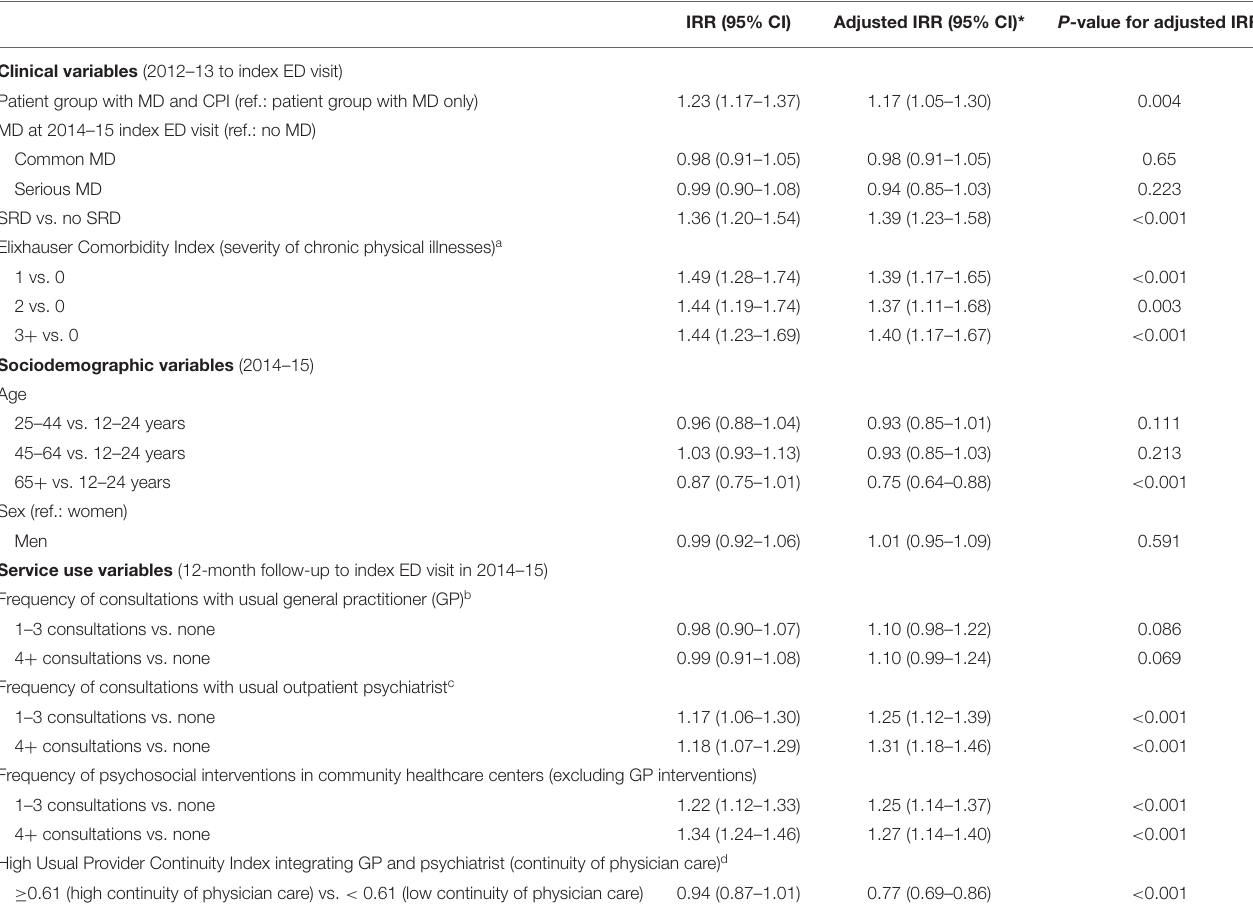
TABLE 3 | Negative binomial model comparing groups of patients diagnosed at onset of mental disorders (MD) including substance-related disorders (SRD) with or without chronic physical illnesses (CPI) on frequency of emergency department (ED) visits for mental health reasons at 12-month follow-up to index ED visit in 2014–15.